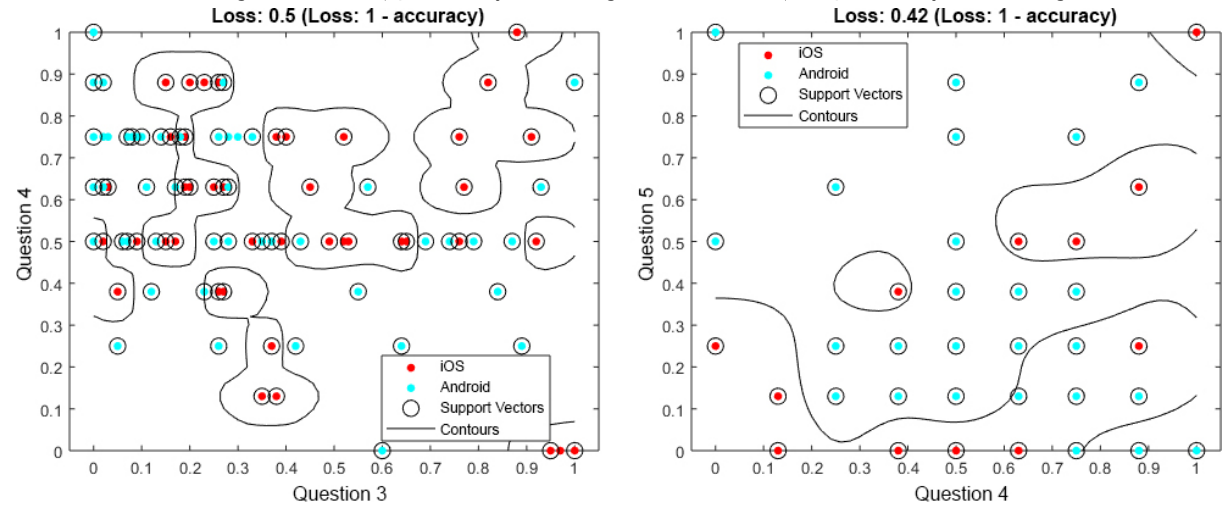
Figure 7. Support vector machine (SVM) results for question 4 (Q4), combined with question 3 (Q3) and question 5 (Q5), from 100 data entries. Q3: How stressful is the tinnitus right now? (slider); Q4: How is your mood right now? (manikins); and Q5: How is your arousal right now?